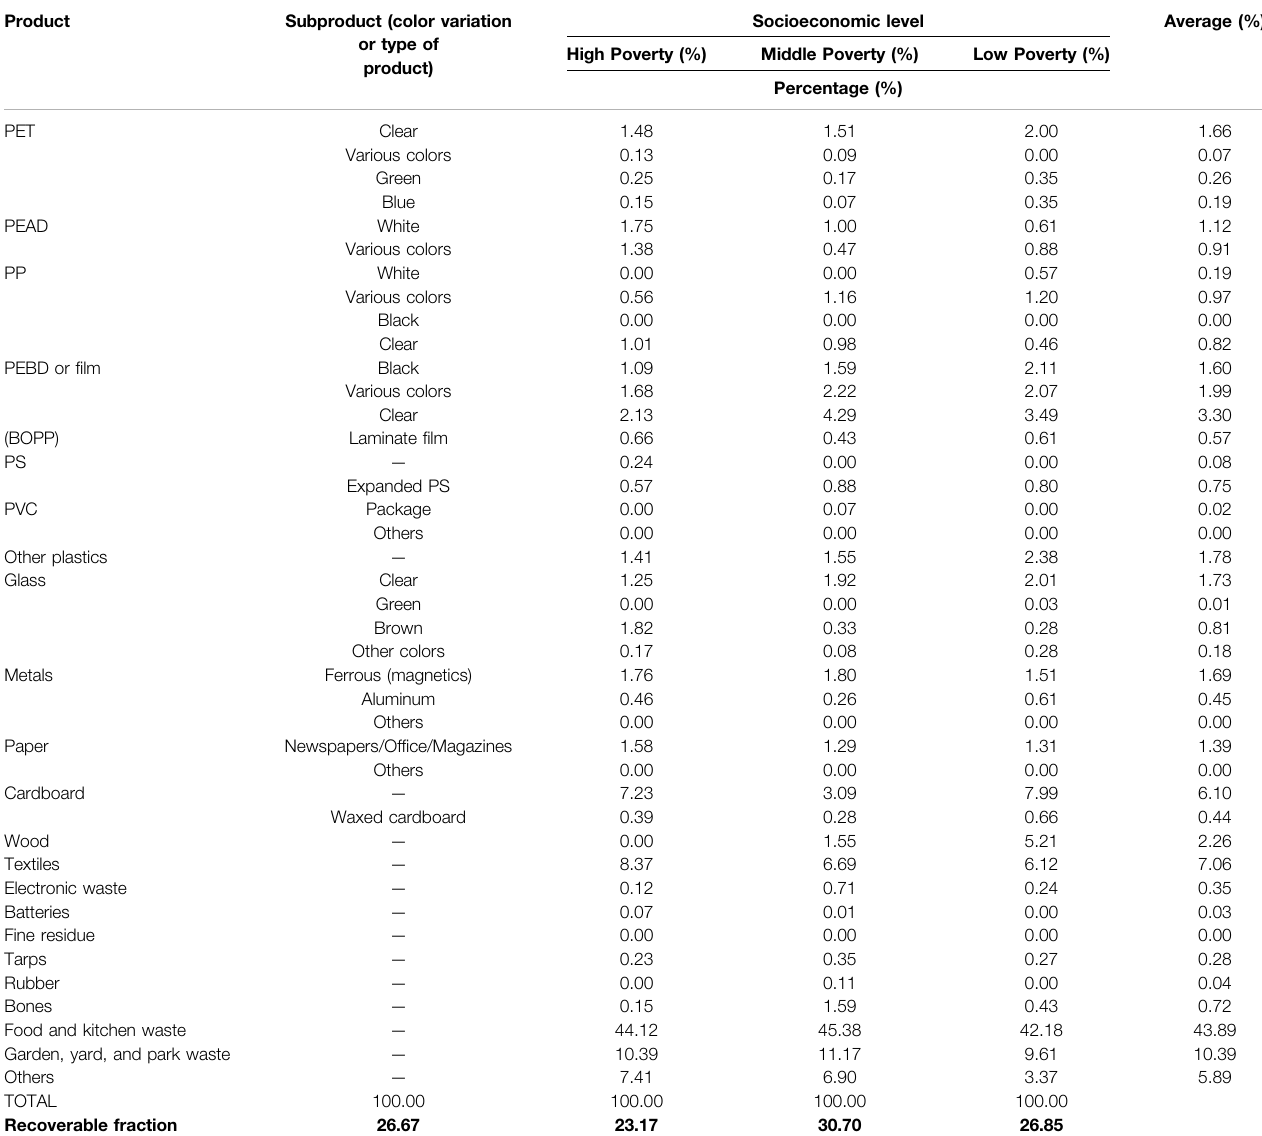
TABLE 2 | Characterization of MSW of the GMA. Product Subproduct (color variation